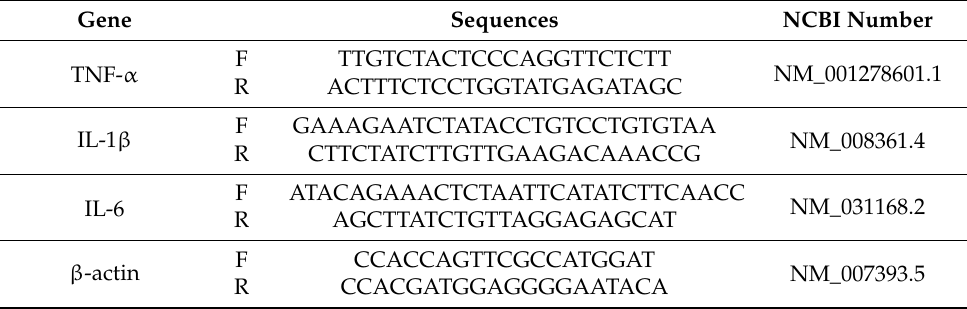
Table 1. Primer sequences for real-time